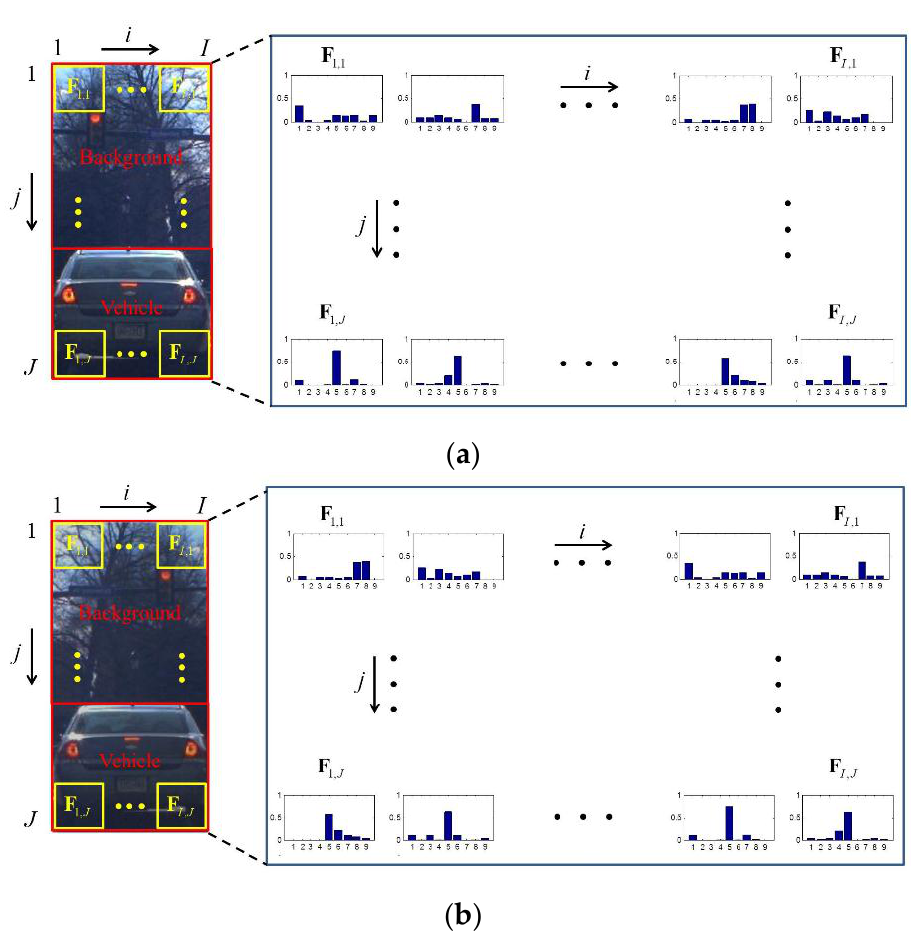
image. Figure 6a,b show examples of the original image and the corresponding flipped image, respectively. For j s that belong to vehicles, the two images are almost the same while, for j s that belong to backgrounds, the two images are different from each other. (2) In order to quantify the symmetry of the given hypothesized window, the similarity between the hypothesized window and the mirror image is computed. Instead of intensity values, gradient values in images are used because they are more robust than intensity values under various illuminations. Thus, the HOG feature vector, is used. The HOG feature is a part of ACF and includes the gradient magnitude and orientation. The HOG feature vector for a hypothesized window can be denoted by H “ histogram of the p i , j q block, and B t denotes the sum of the gradient magnitudes according to the i , j orientation bin t in the p i , j q block, where I and J are the numbers of column and row blocks of the window, respectively, as shown in Figure 6; T denotes the number of orientation bins in the HOG; i , j and t are the indices for I , J and T , respectively.